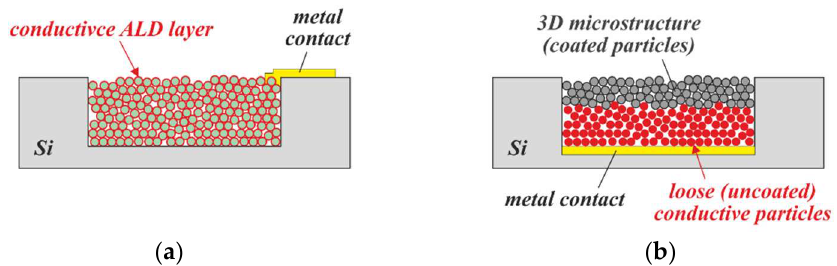
Figure 22. Concepts for large-surface-area electrodes manufactured via the PowderMEMS process: ( a ) Electrode formed by coating of the porous structure with a conductive ALD layer. ( b ) Electrode formed by confining a loose conductive powder inside a cavity.